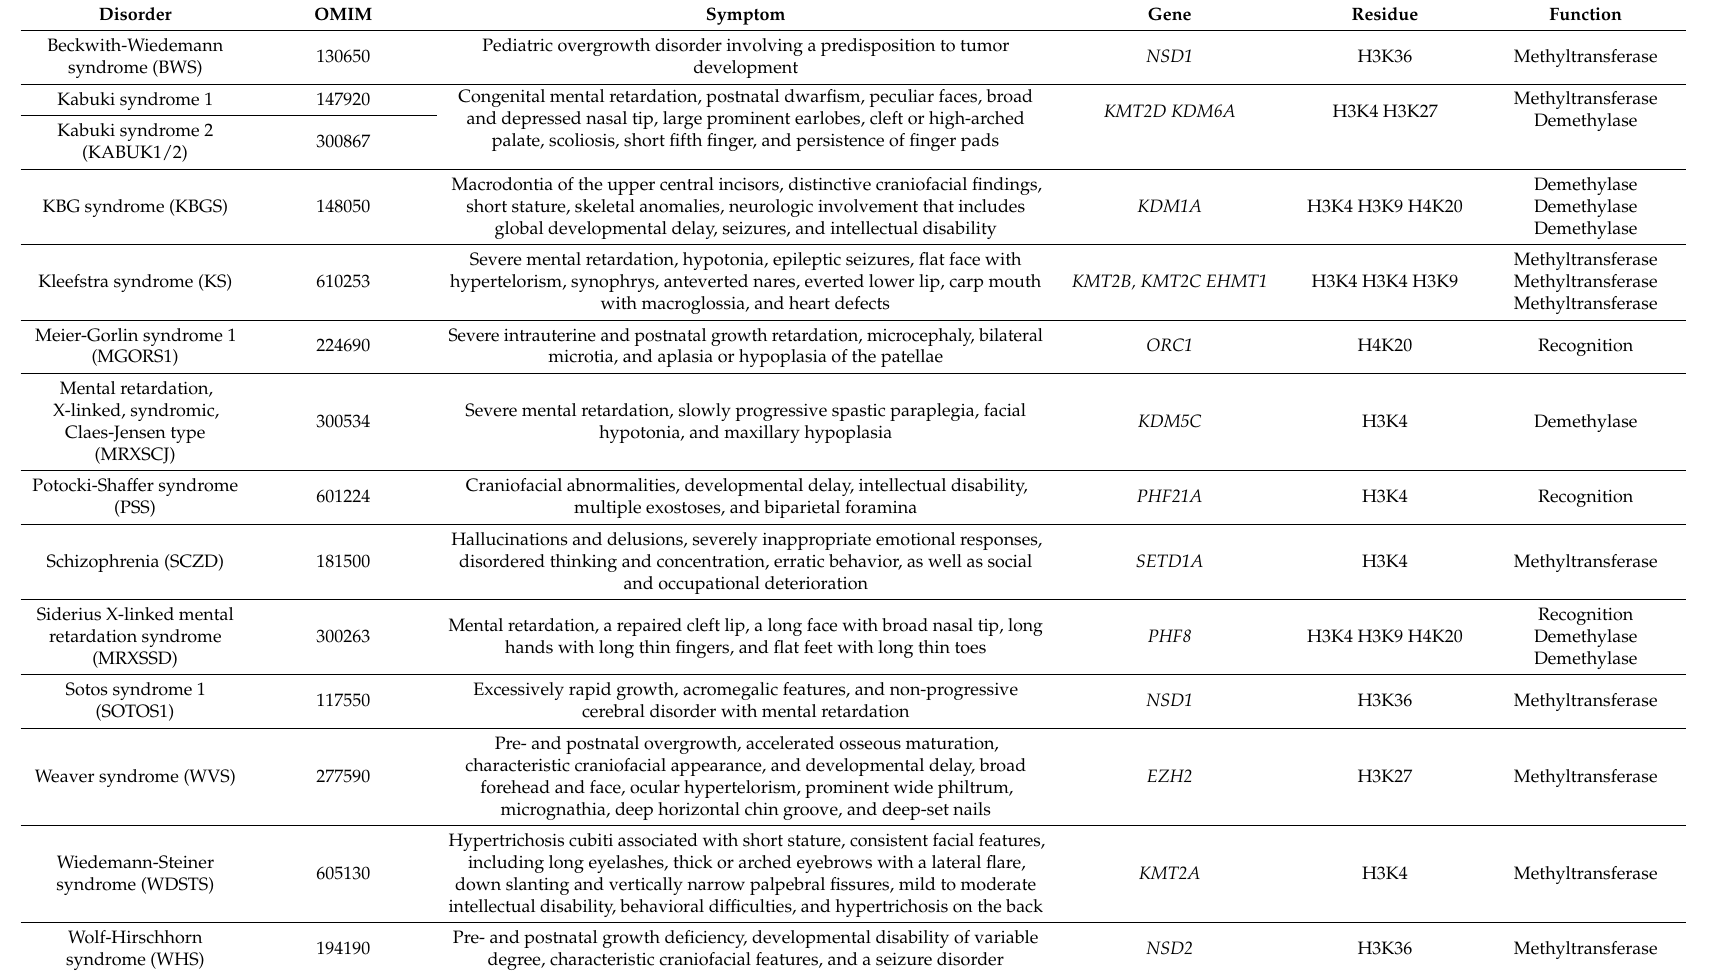
Table 2. Neurodevelopmental disorders caused by mutations in histone methylation-related